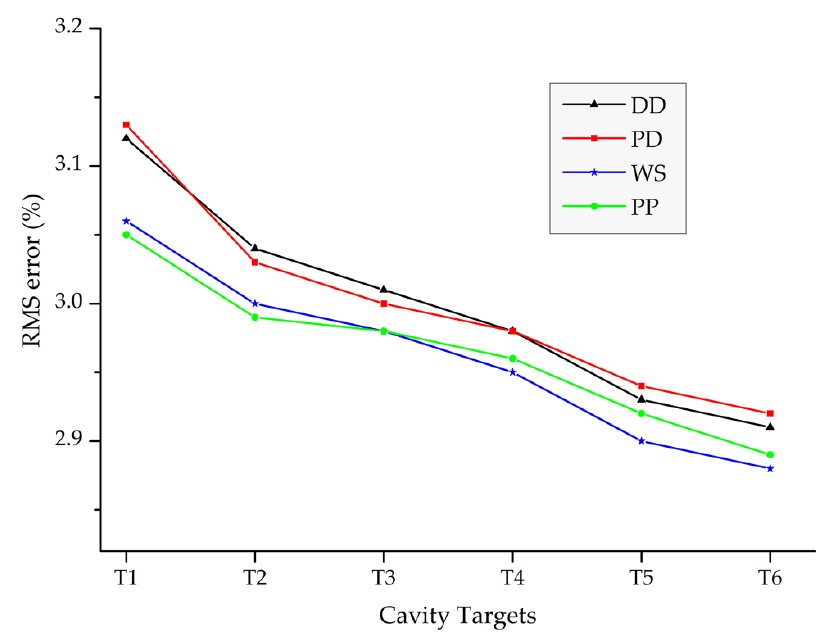
Figure 5. Arrays’ inversion error for varying air-filled cavity depths.